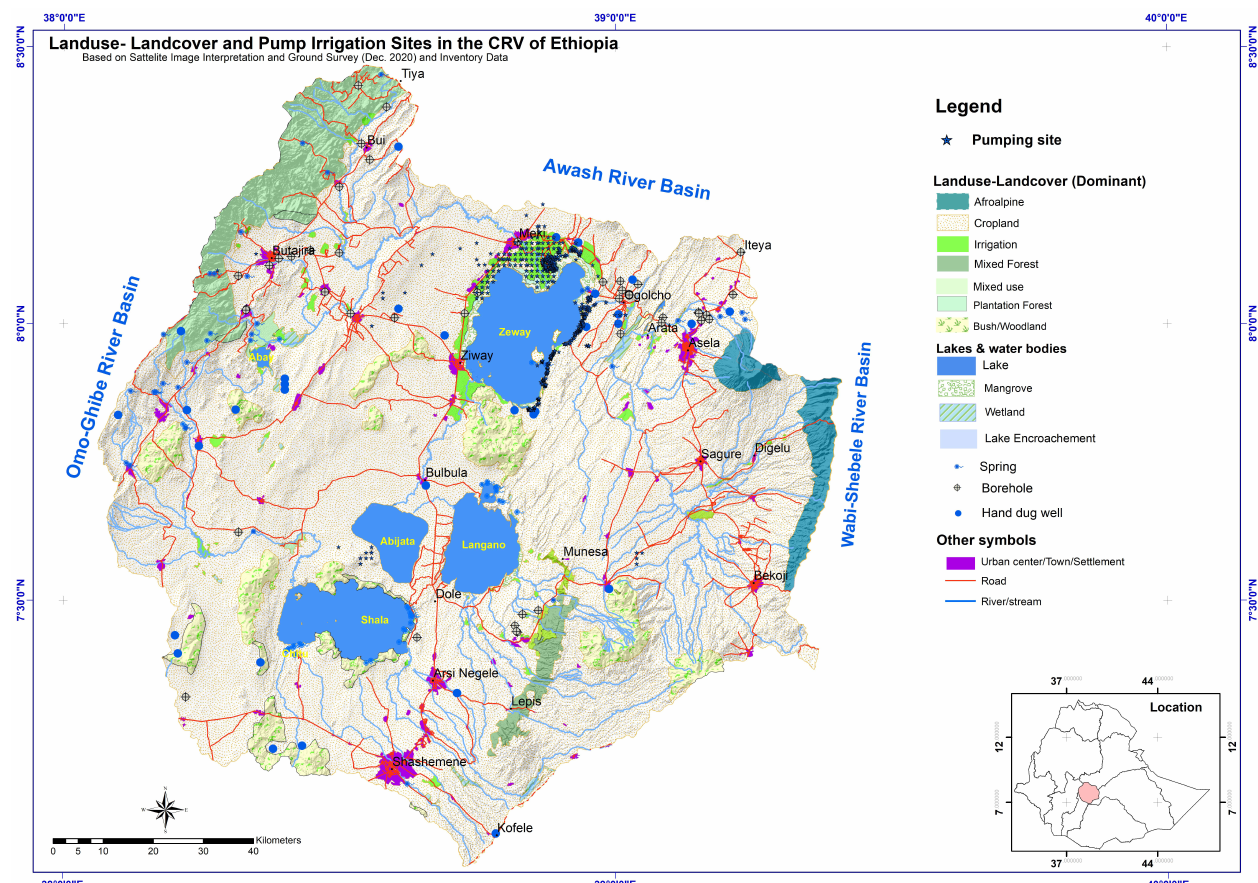
Figure 3. Water abstraction sites along rivers and around lakes in the upper CRV (note the distribution of pumping and diversion areas along the altitudinal gradients, showing the need for upstream- downstream